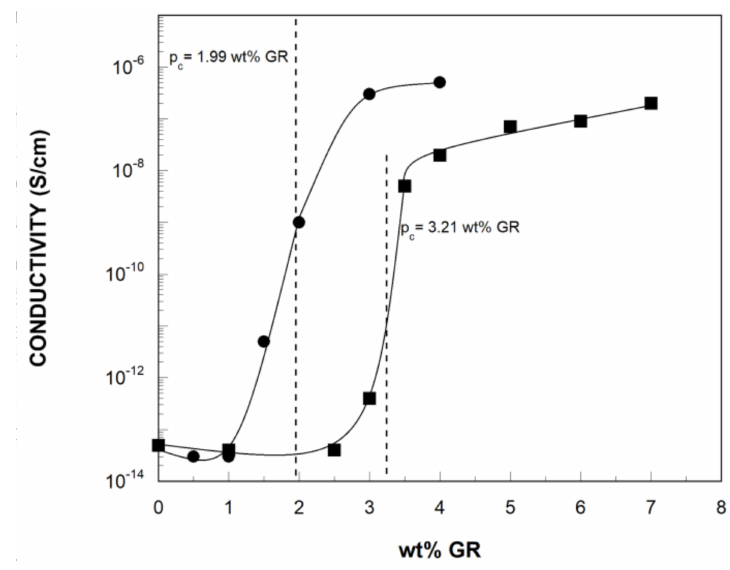
Figure 3. Electrical conductivity of the bTPU/GR ( (cid:4) ) and bTPU/GR-IL ( • ) NCs as a function of the GR content. The dotted lines mark the calculated p c